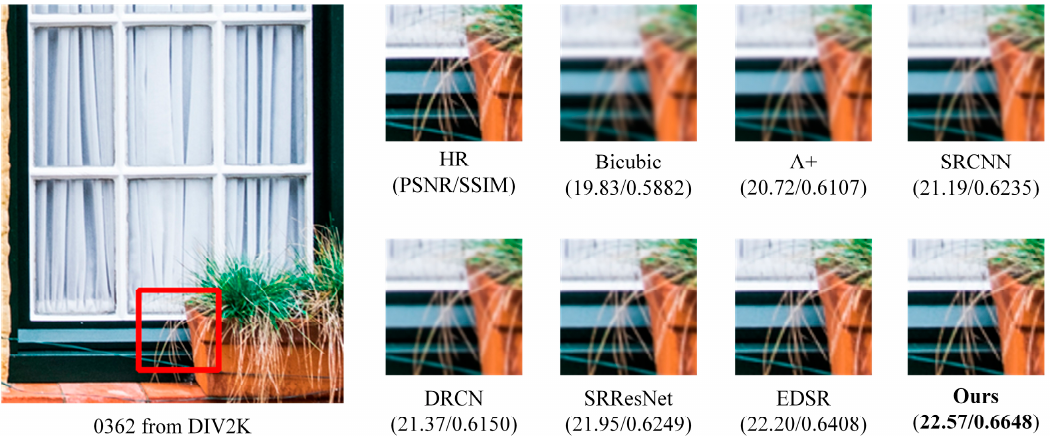
Figure 3. The results of “Image0362” (DIV2K) on ×4 super-resolution. MRSR shows a better performance in the qualitative comparison with other methods.